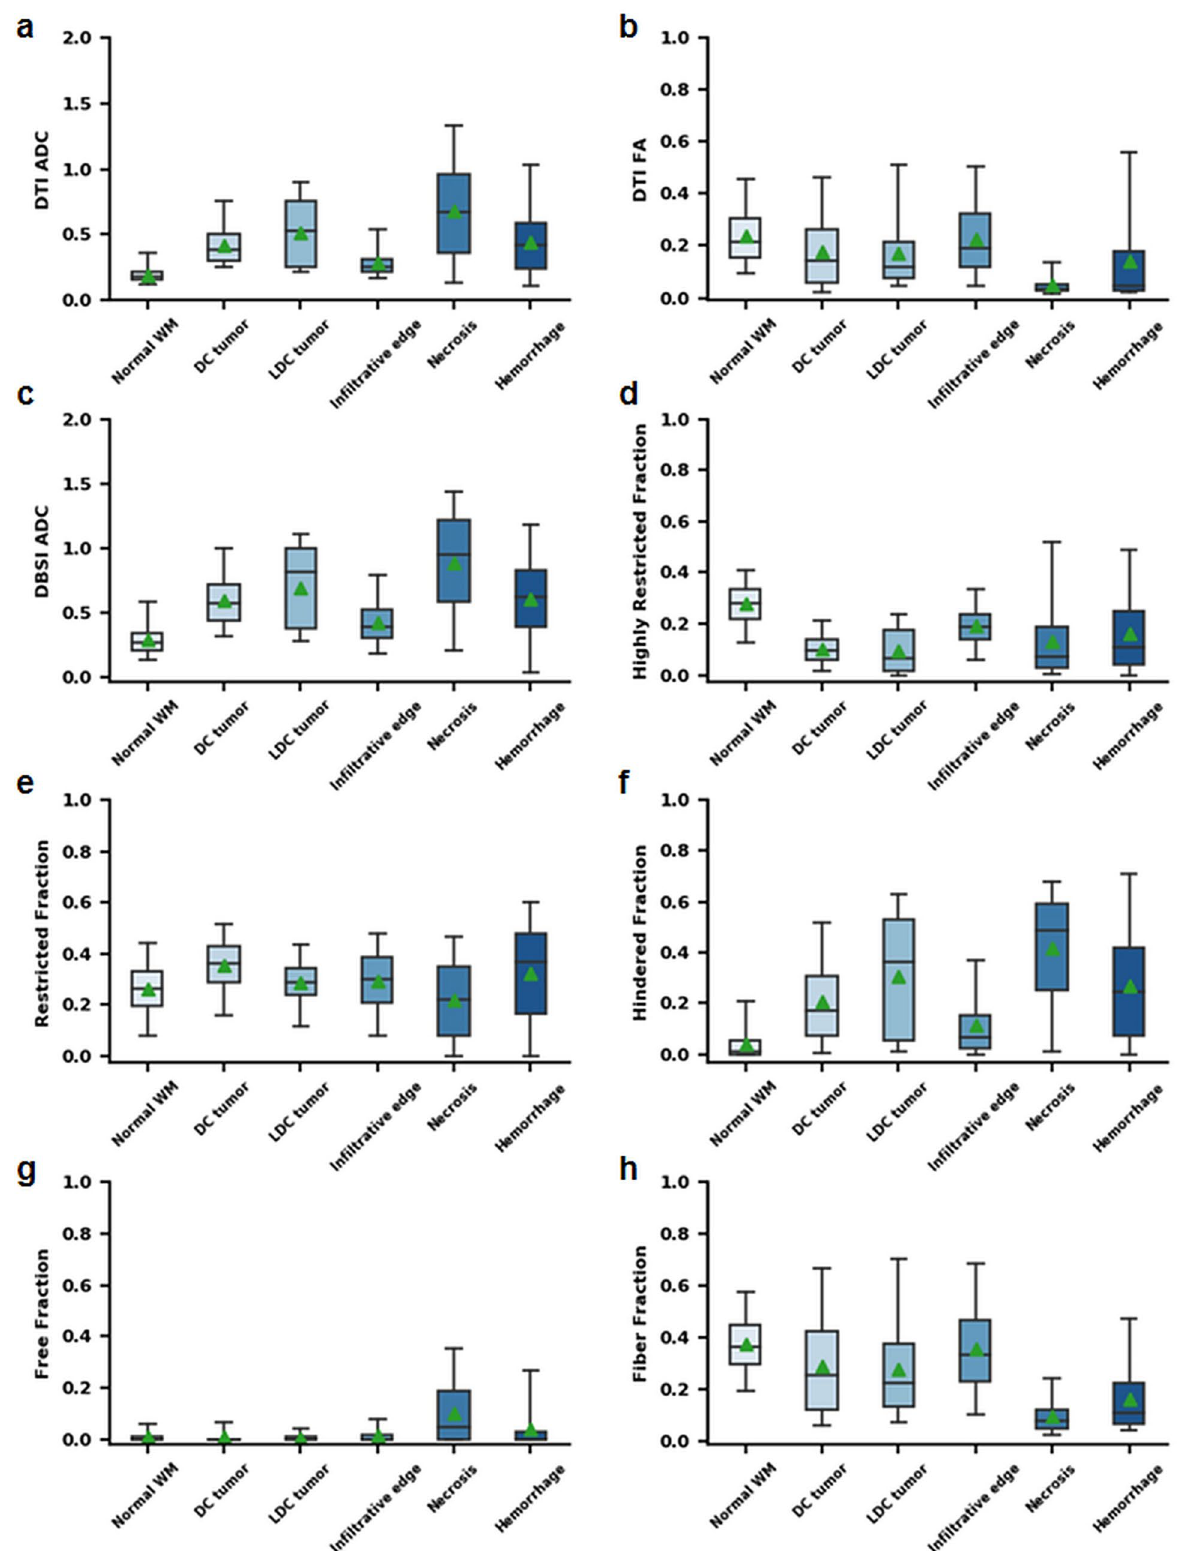
Figure 4. Group analysis on different tumor histologic components on representative diffusion metrics including ( a ) ADC, ( b ) DTI FA, ( c ) DBSI isotropic ADC, ( d ) highly restricted fraction, ( e ) restricted fraction, ( f ) hindered fraction, ( g ) free fraction, and ( h ) fiber fraction. Particularly, normal WM and the infiltrative edge showed higher fiber fraction and DTI-FA than the other tumor histologies. DC tumor and LDC tumor showed higher restricted fraction values than other histologies. Necrosis showed higher ADC, hindered fraction and free fraction values as well as lower restricted fraction, fiber fraction and DTI-FA compared to the other histologies. These findings were collectively consistent with DBSI’s modelling for malignant brain tumor. ADC, µm 2 /ms. Normal WM normal white matter, DC tumor densely cellular tumor, LDC tumor less densely cellular